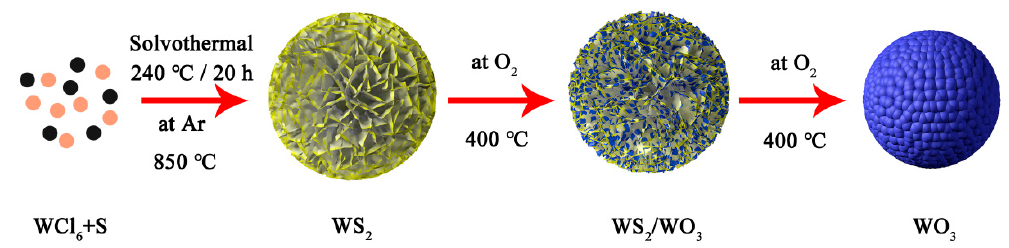
Figure 1. Schematic illustration of the synthetic procedure of WS 2 , WS 2 /WO 3 , and WO 3 .